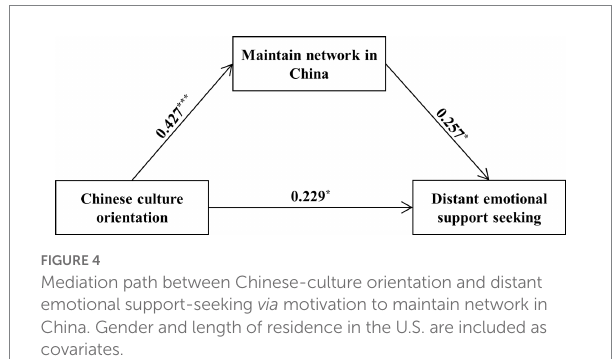
FIGURE 4 Mediation path between Chinese-culture orientation and distant emotional support-seeking via motivation to maintain network in China. Gender and length of residence in the U.S. are included as